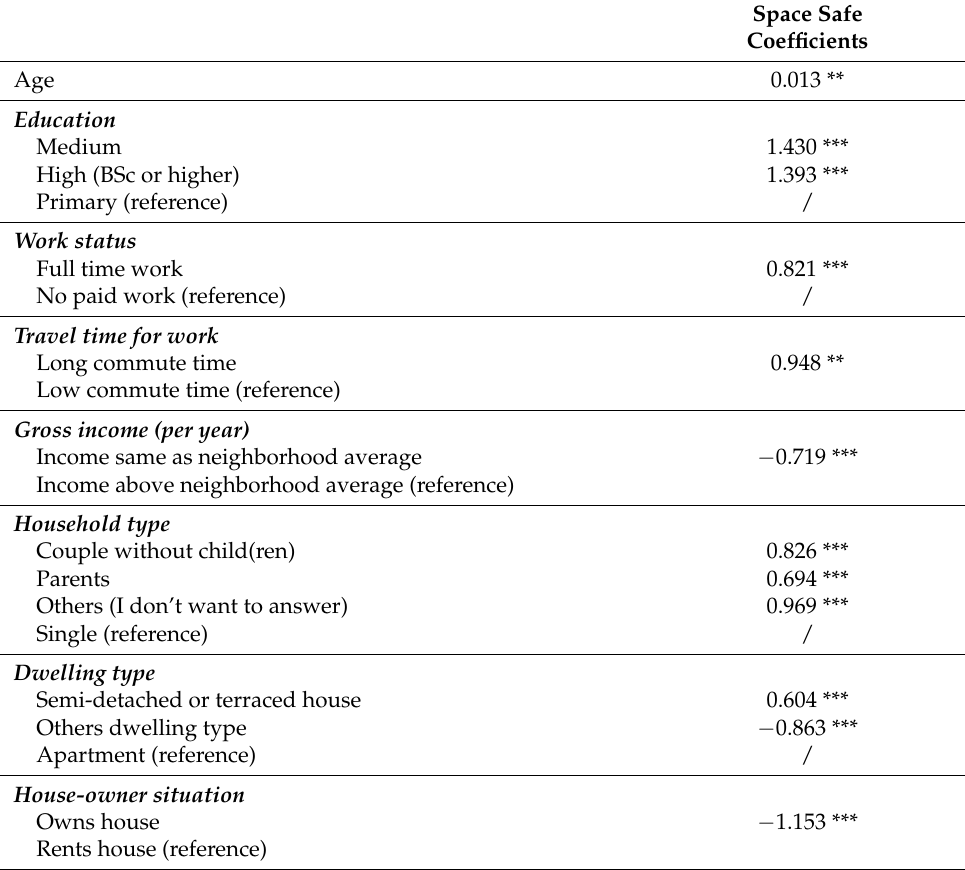
Table 14. Results of the MNL models ( secure sense